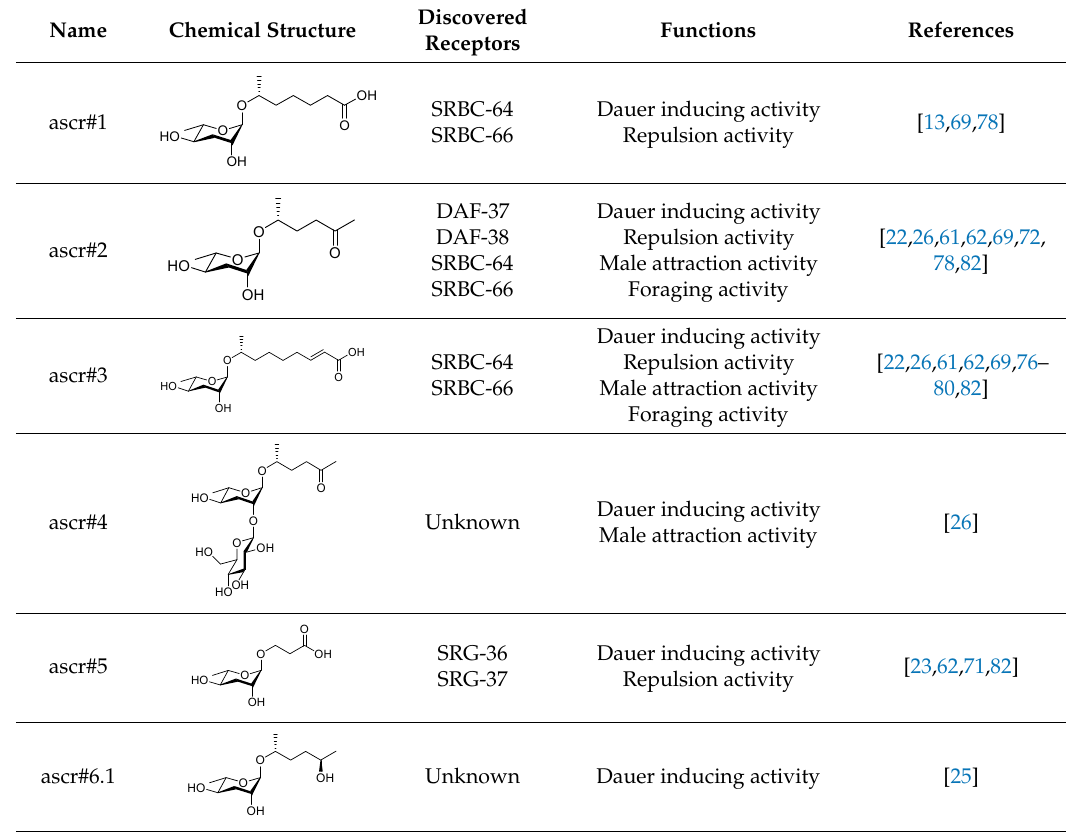
Table 1. The functions and structure of some ascaroside pheromones *.